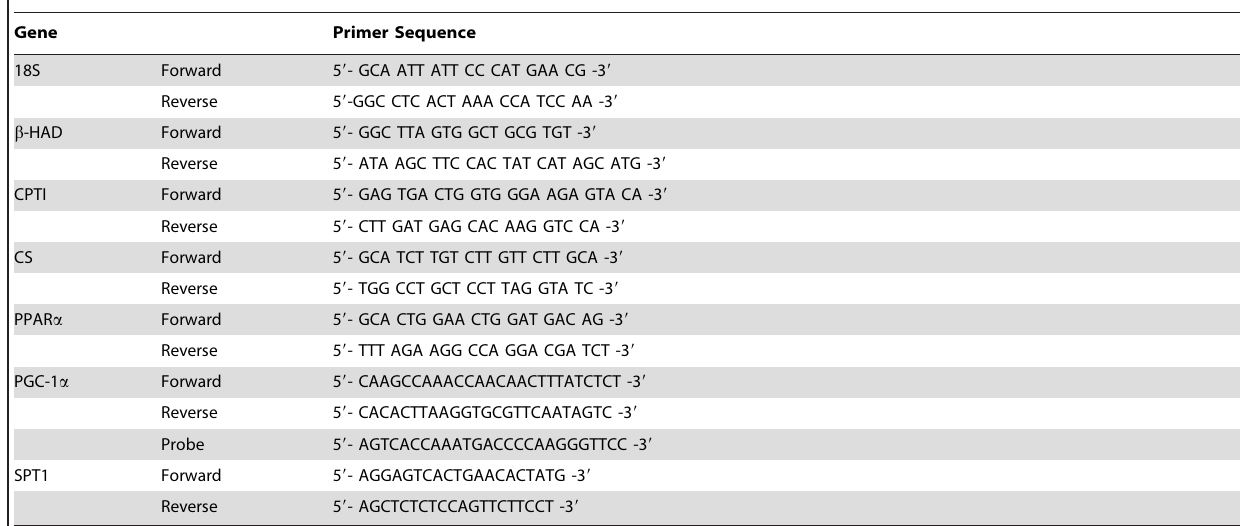
Table 2. Primer sequences used for real time-PCR.